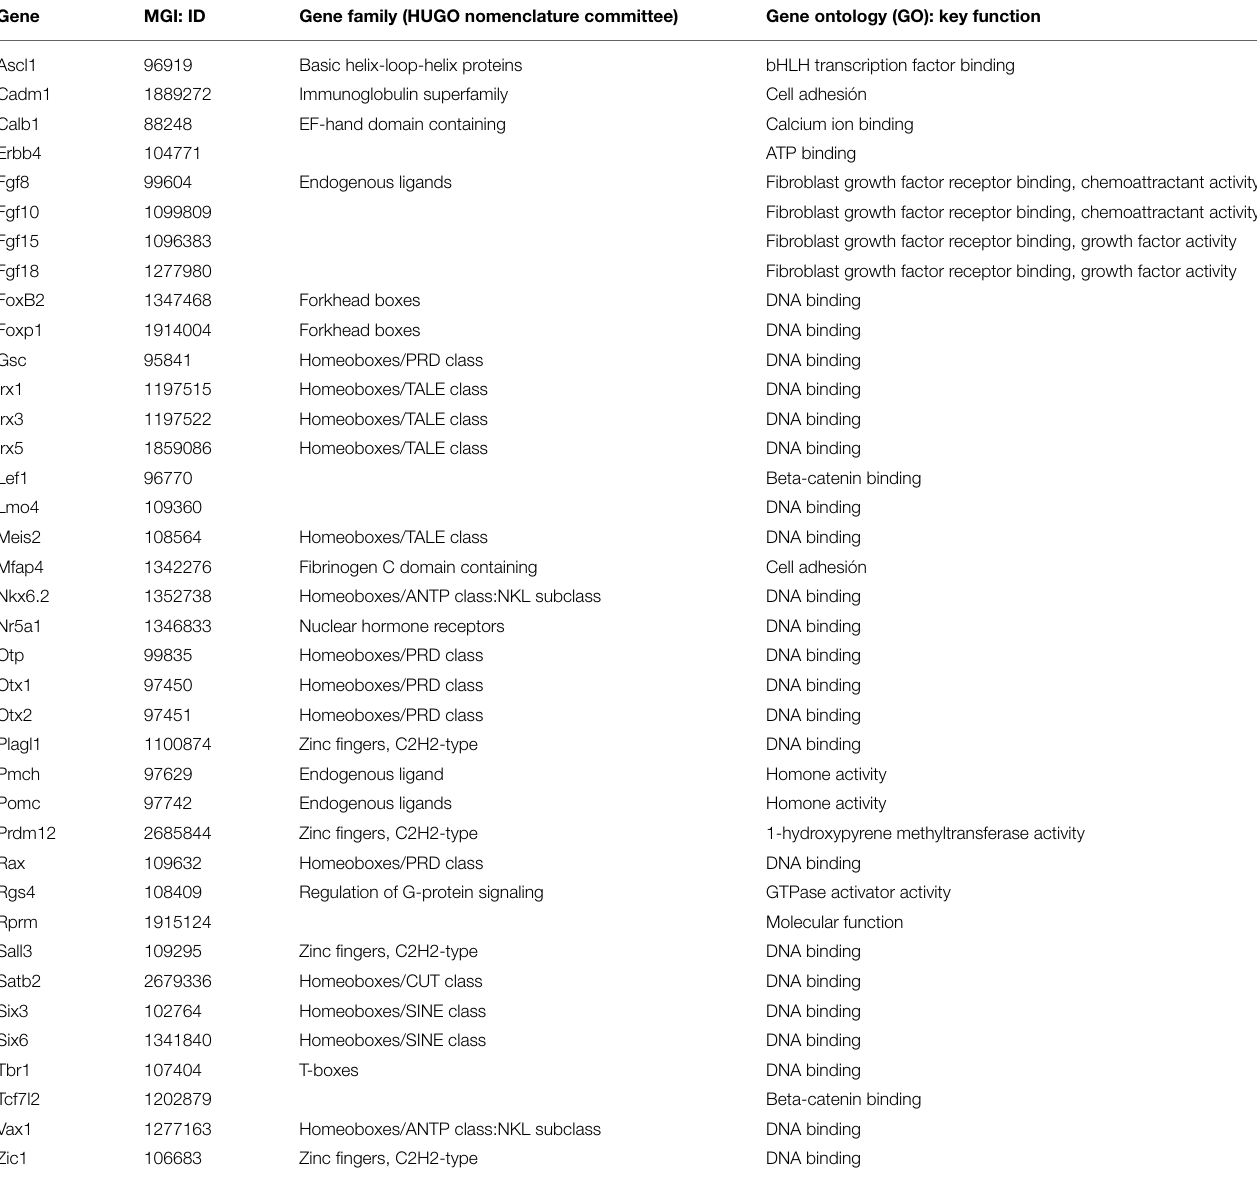
TABLE 1 | 37 genes analyzed, classified according to their mouse genome informatics ID, gene family classification (HUGO) and functional gene ontology